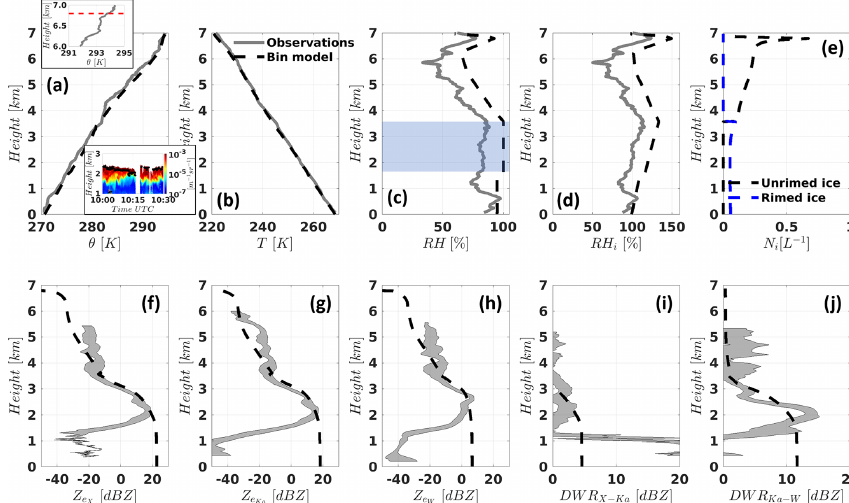
Figure 13. Sounding (10:24UTC) and radar (09:30–09:55UTC) measurement profiles together with the bin model output at the end of the 8h simulation. (a) Potential temperature ( θ ), (b) temperature, (c) relative humidity (RH), (d) RH with respect to ice (RH i ), (e) unrimed and rimed ice number concentration (model only; see legend), (f) measured temporal mean ± 1 standard deviation XSACR (shaded region) plus model forward-calculated X-band (dashed black line) reflectivities, (g) as in (f) but for KAZR (Ka band), (h) as in (f) but for MWACR (W band), (i) as in (f) but showing the DWR X , Ka , and (j) as in (f) but showing the DWR Ka , W . The blue-shaded rectangle in (c) represents the estimated supercooled cloud extent (see text). The insets in panel (a) depict the θ profile between 6 and 7kma . s . l . altitude with the dashed red line designating the RH peak (see c ) at ∼ 6 . 8kma . s . l . (top), and backscatter cross section measured with the HSRL around radiosonde release time together with liquid cloud base heights (black markers; see Silber et al., 2018b,